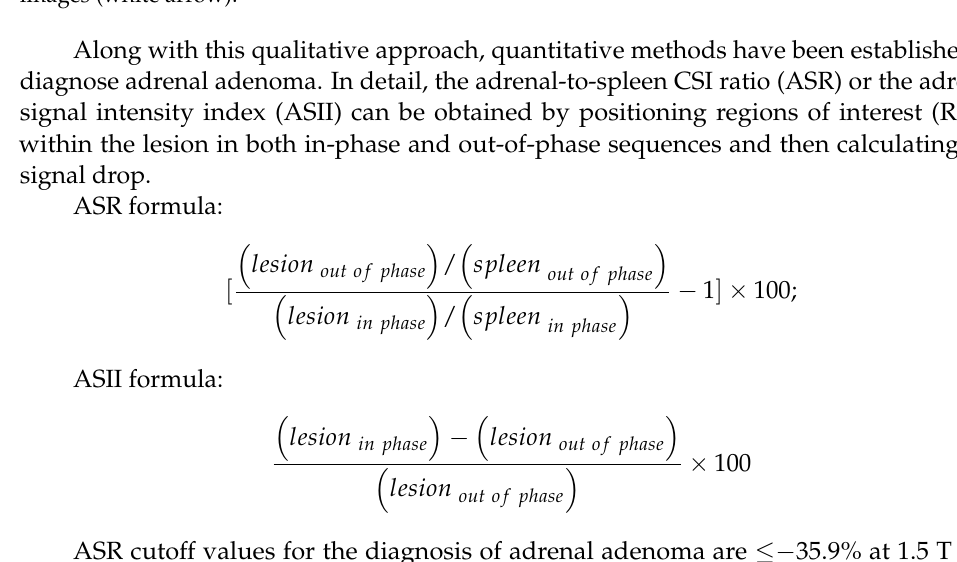
Figure 1. Adrenal adenoma in a 63-year-old woman. Unenhanced CT ( a ) shows a 2 cm left adrenal lipid rich adenoma (yellow arrow) characterized by attenuation values lower than 10 HU. Axial T1- weighted in-phase ( b ) and out-of-phase ( c ) MR images demonstrate a signal loss in the out-of-phase images (white arrow).